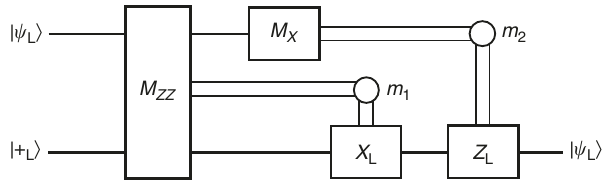
Fig. 3 Circuit for measurement-based information processing implemented via lattice surgery. The upper and lower single, horizontal lines correspond to the logical qubits encoded in the color and surface codes, respectively. M ZZ and M X are projective measurements that project onto an eigenstate of ⊗ Z X ⊗ 1 M Z ZZ is implemented through the merging L L and L L respectively. protocol and code splitting described in the main text. The double lines labeled m 1 and m 2 represent classical conditioning of the X L and Z L gates on the measurement outcomes m 1 and m 2 ,